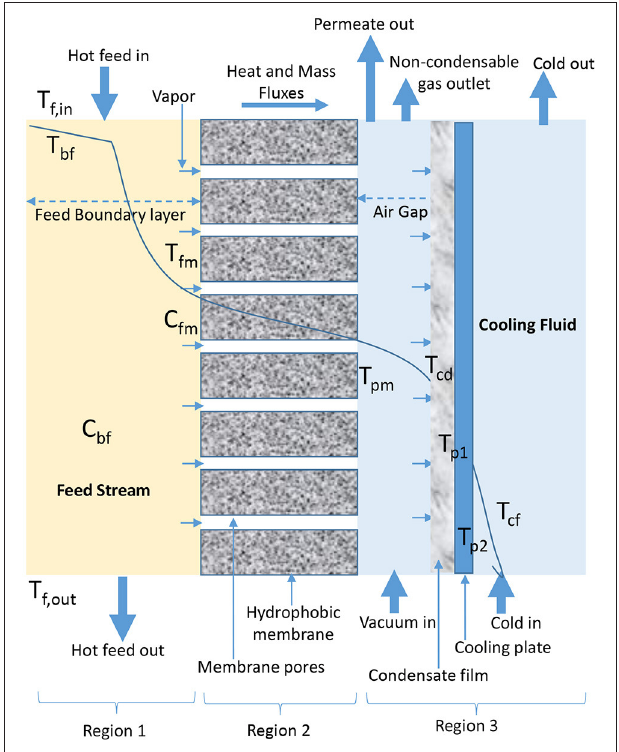
FIGURE 5 | Heat and mass transfer in LGMD configuration.